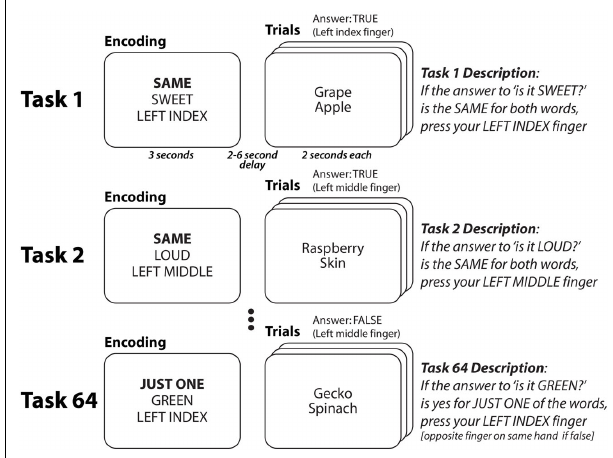
FIGURE 1 | Cognitive paradigm to investigate rapid instructed task learning. Participants performed 64 distinct tasks in randomly intermixed short blocks (see Cole et al., 2010a for more details).Tasks were conceptualized as collections of rules. Each word was presented separately, but they are grouped here to facilitate illustration. Each task consisted of a decision rule (highlighted here in bold, though not for participants) and a semantic rule + response rule combination.Thus, each of the four decision rules could appear in any of 16 task contexts (four decision ∗ 16 semantic/response = 64 tasks). Four of the tasks (counterbalanced across participants) were practiced for 2h in a prior session. For all participants there was one practiced task per decision rule, and no overlap between the semantic and response rules across practiced